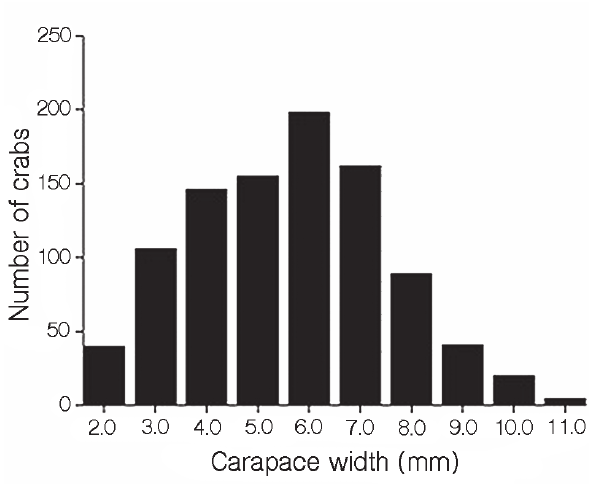
Figure 3. Size frequency distribution of body size (CW) of Panopeus austrobesus in the mussel farm at Itaguá Beach, Ubatuba, State of São Paulo, Brazil.